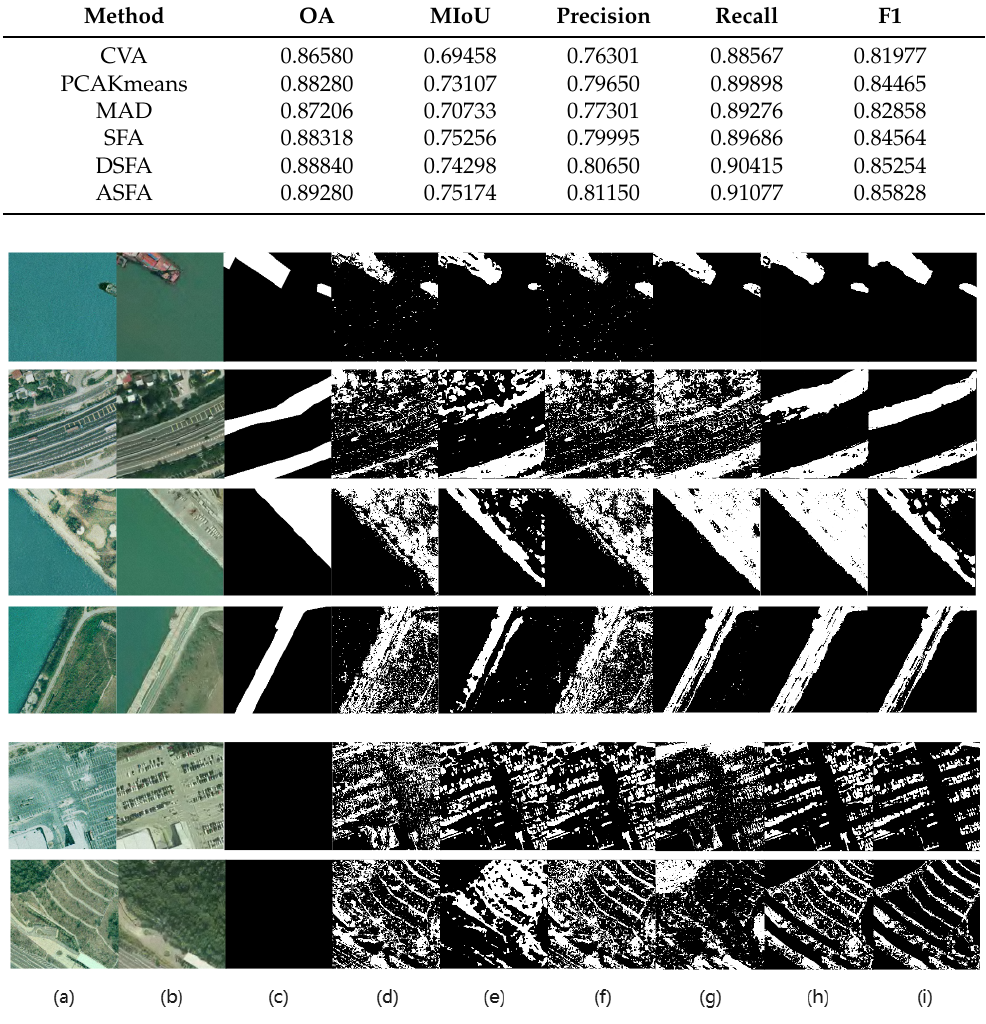
Figure 7. The change maps on SYSU-CD.( a ) image 1; ( b ) image 2; ( c ) ground truth; ( d ) CVA; ( e ) PCAKmeans; ( f ) MAD; ( g ) SFA; ( h ) DSFA; ( i )